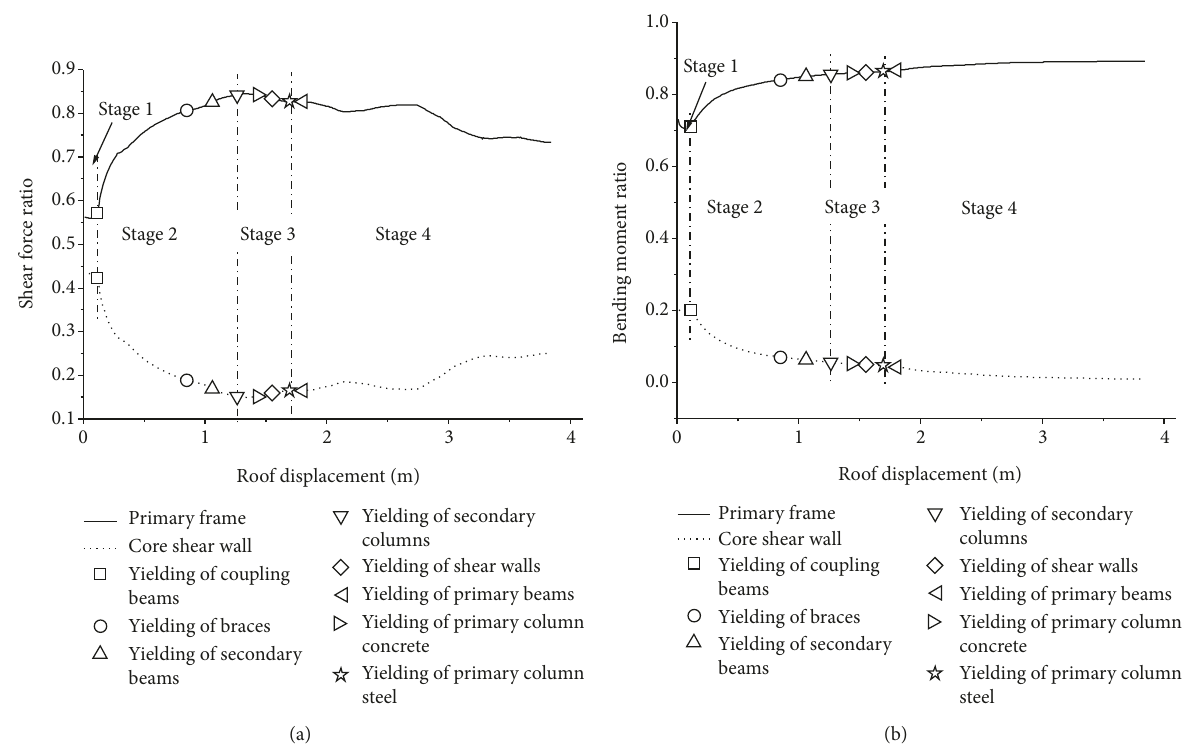
Figure 14: Internal force coefficient of model 5MXBC: (a) shear force ratio; (b) bending moment